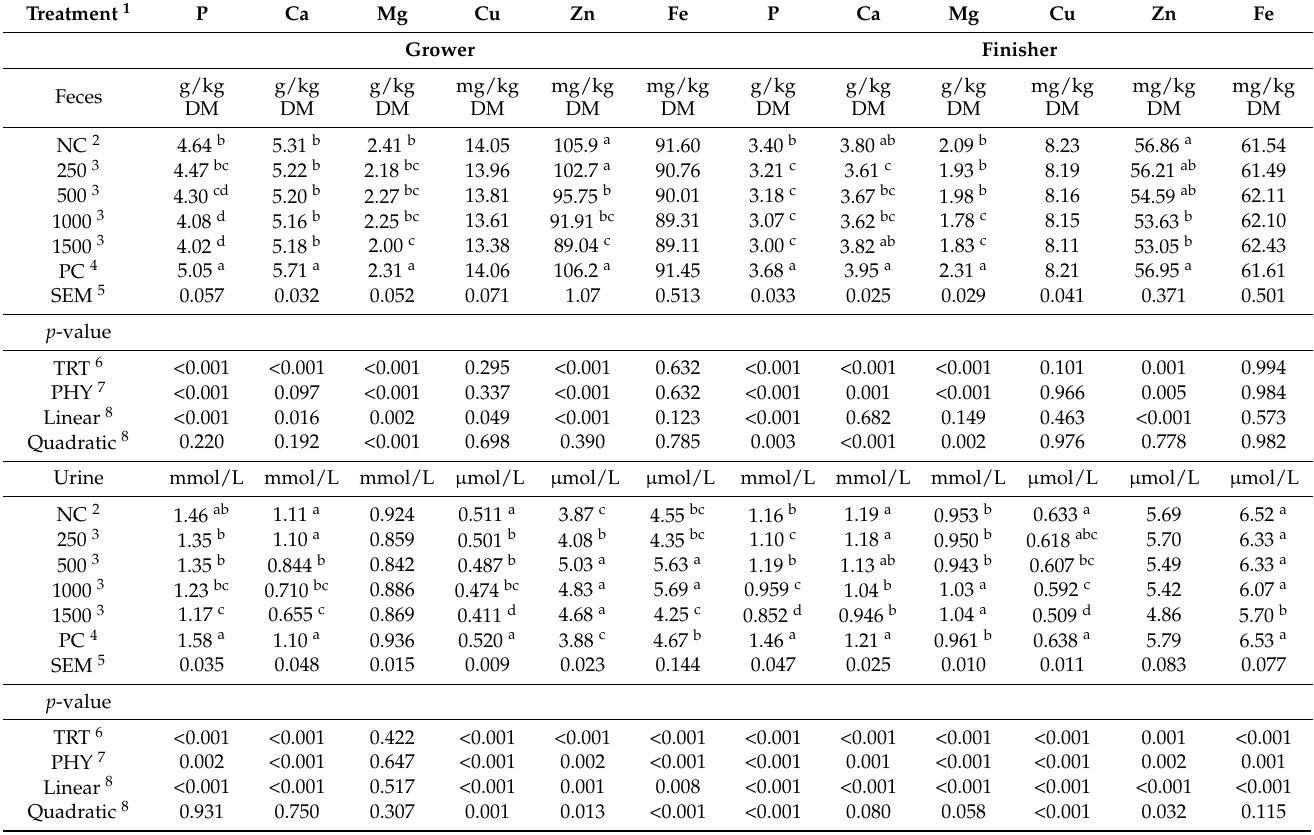
Table 4. Mineral content in the feces and urine of growing–finishing